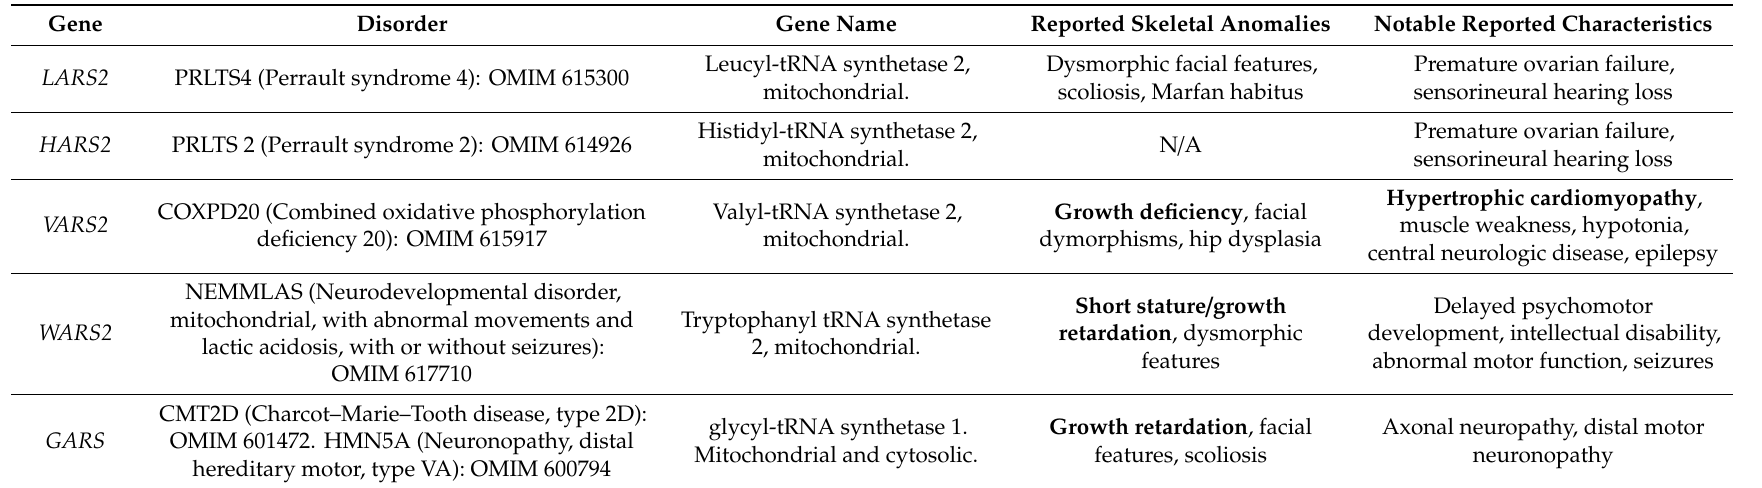
Table 5. Subset of genes encoding mitochondrial aminoacyl tRNAs implicated in mitochondrial disease, indicating formal OMIM (Online Mendelian Inheritance